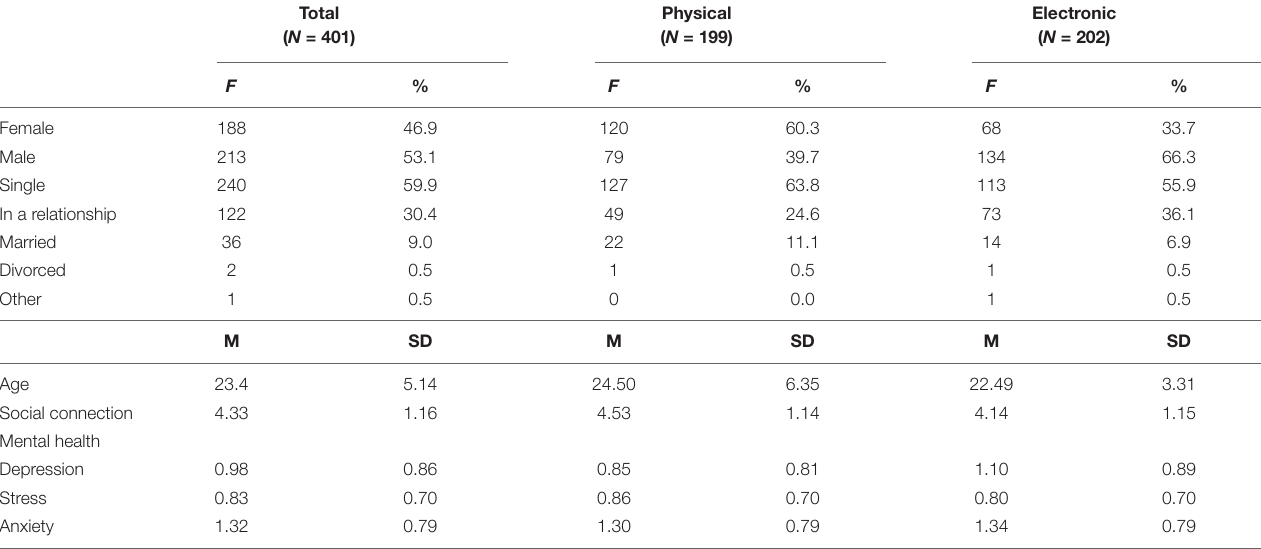
TABLE 1 | Descriptive analyses of social connection and mental health.